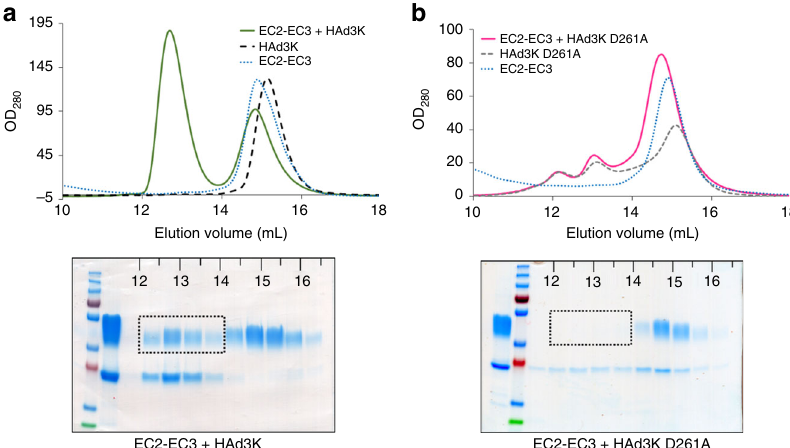
Fig. 3 A single D261A mutation in HAd3K is suf fi cient to abolish the receptor binding. a HAd3K incubation with an excess of EC2-EC3 produced in mammalian cell resulted in a complex eluted between 12 and 14 mL as shown by SEC and con fi rmed by SDS-PAGE. b Incubation of EC2-EC3 with the D261A mutated HAd3K resulted in a pic eluted latter (14 – 16 mL) corresponding to the two free components as shown by SDS-PAGE. Dotted rectangles on SDS-PAGE indicates the expected position of EC2-EC3 when in complex with the knob